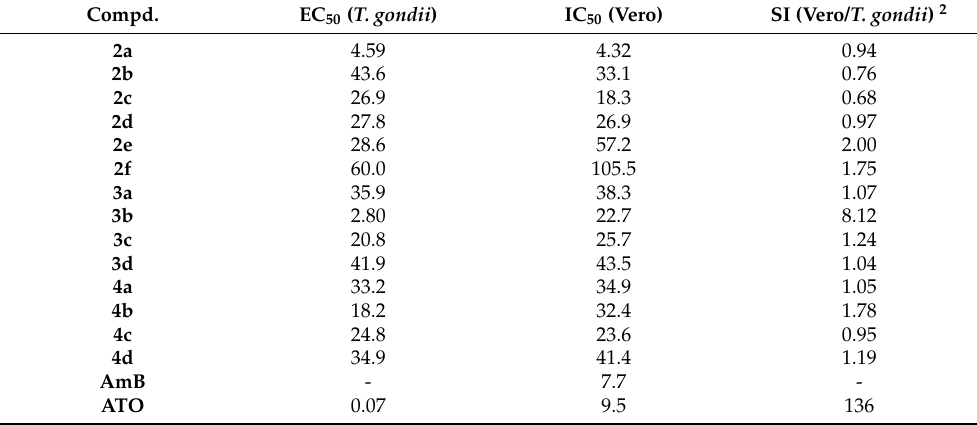
Table 1. Inhibitory concentrations IC 50 (in µ M, after 72 h) of test compounds in Vero cells (African green monkey kidney epithelial cells), and effective concentrations EC 50 (in µ M, after 72 h) in Toxoplasma gondii . 1 Amphotericin B (AmB) and atovaquone (ATO) served as positive control drugs. Compd.